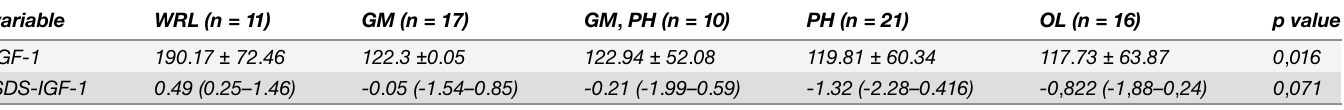
Table 3. IGF-1 levels and SDS in patients without renal lesions and in those with different types of lesions. variable